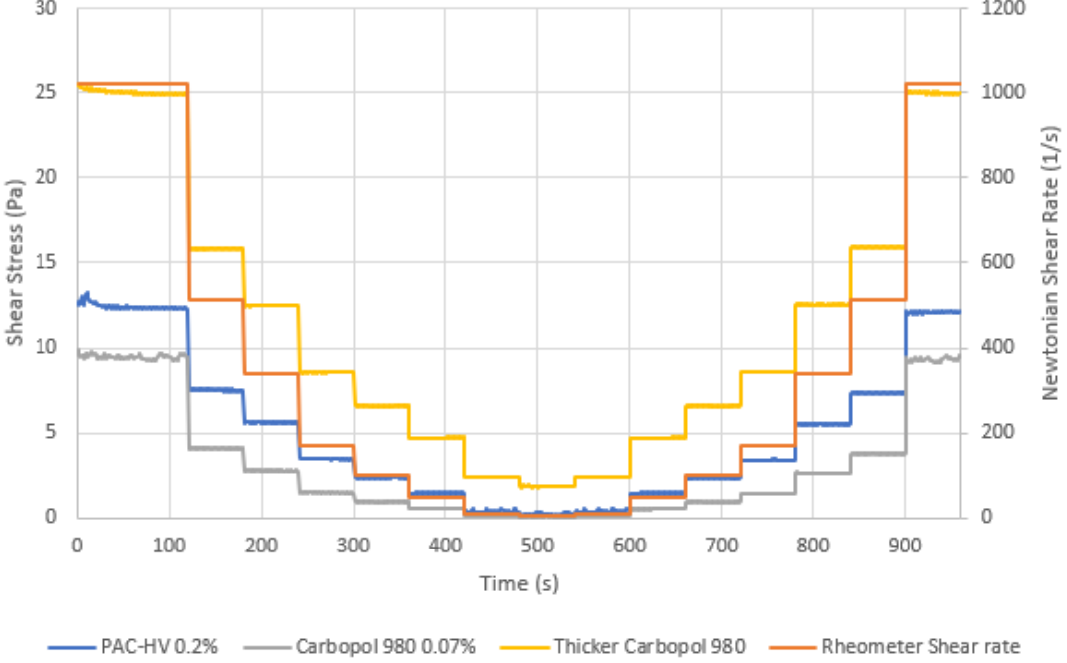
Figure 14. With non-thixotropic fluids, the shear stress reaches a stable value almost immediately after each change in rheometer speed.